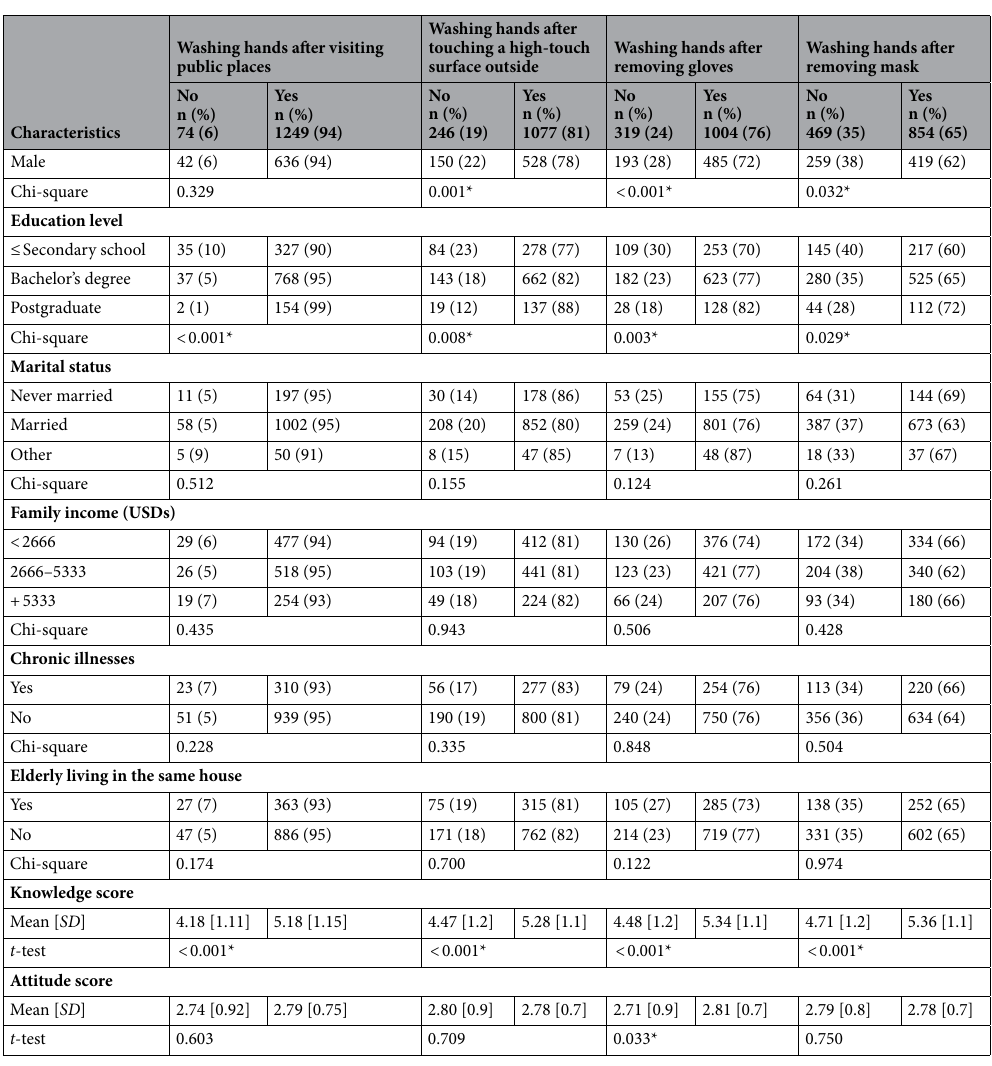
Table 6. Bivariate analysis of factors associated with handwashing practice (technique, duration, and